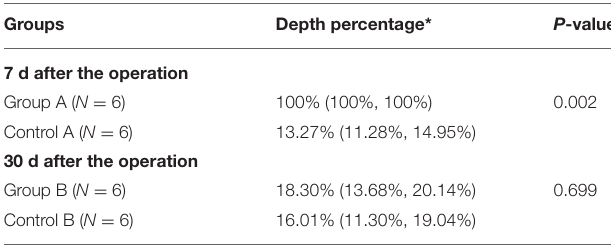
TABLE 2 | Pathology summary of Group A and B. Group